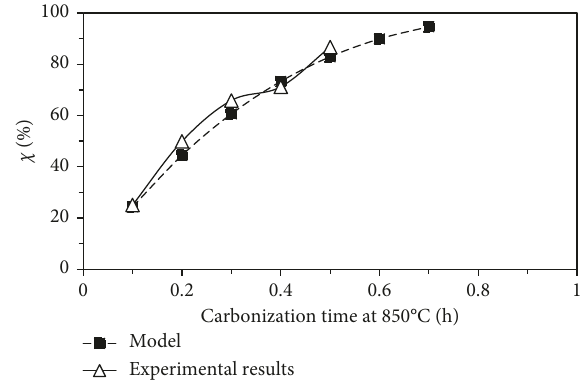
Figure 5: Conversion according to experimental results and Not Reacted Core model.